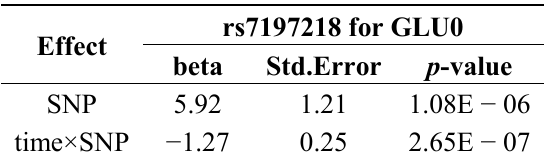
Table 7. Gene × environment interaction effect in the KARE cohort. Interactions of time interval with SNP were tested, and p -values for SNPs with genome-wide significant interaction are listed.